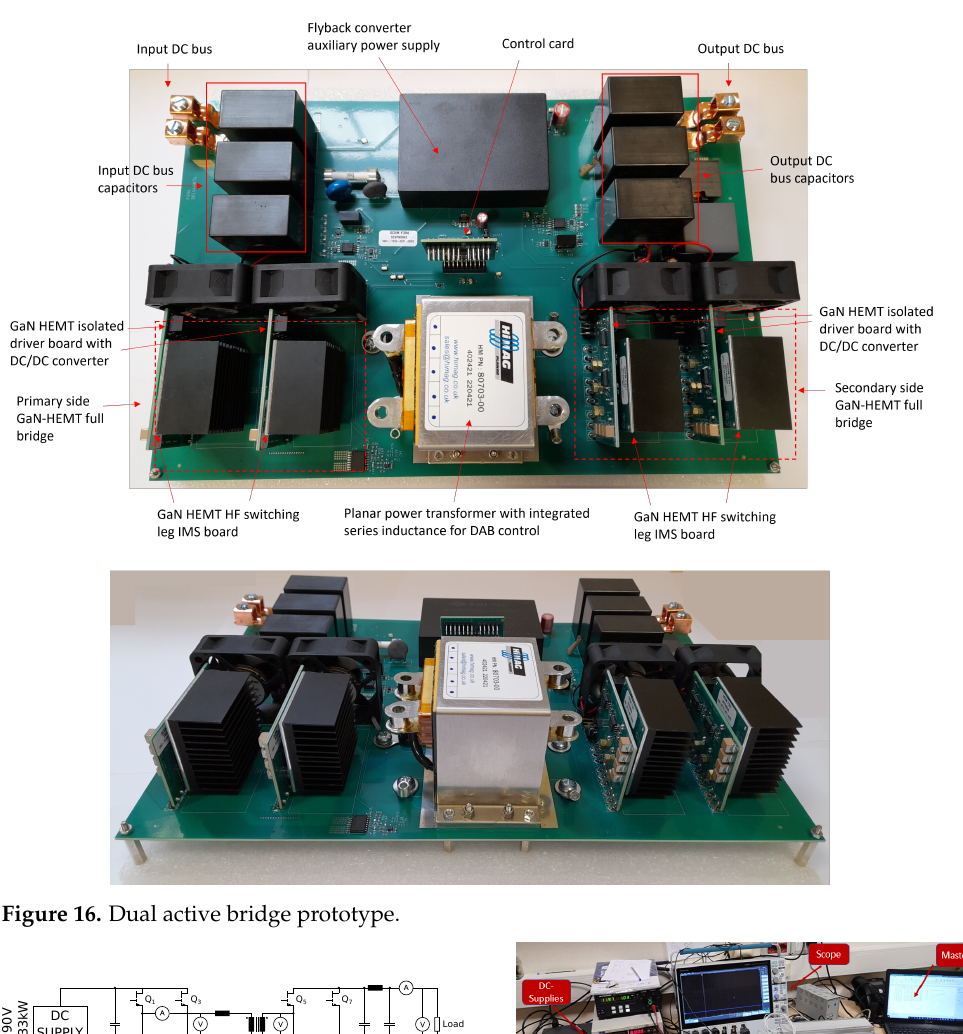
Figure 16. Dual active bridge prototype.